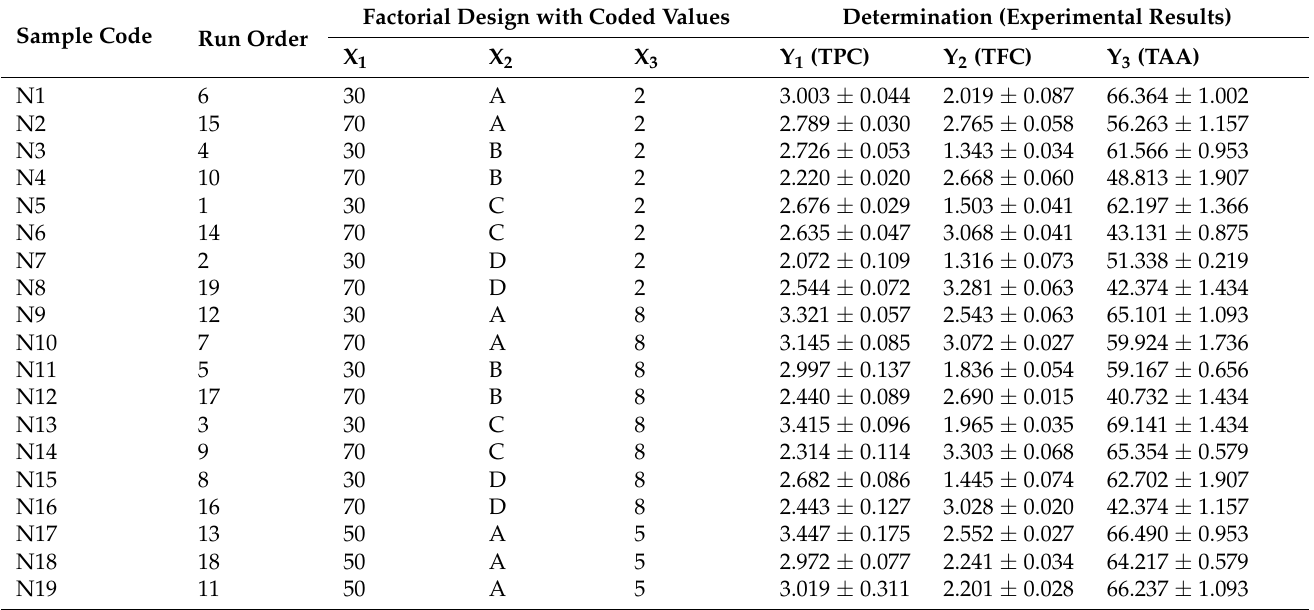
Table 3. Matrix of the experimental design for the screening step and the results of total phenolic content, total flavonoid content, and total antioxidant activity for the extracts of E. hirsutum